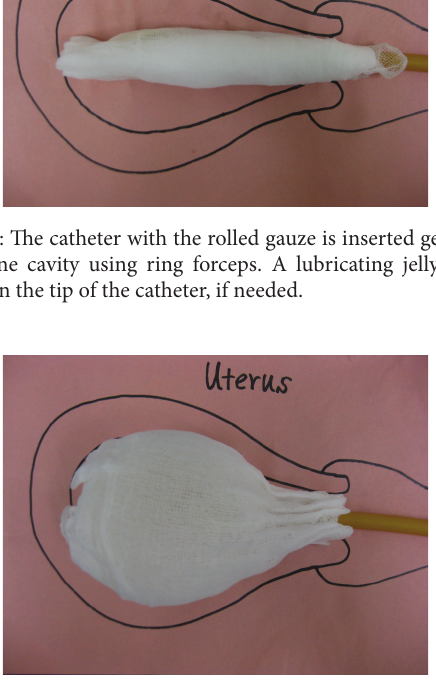
Figure 4: The balloon is inflated with sterile water until it bulges toward the cervix so that it can adequately compress the inner uterus and the tranexamic-acid-soaked gauze can adhere tightly to the bleeding spots. In addition, one-meter long normal gauze is packed in the vagina to prevent the balloon from slipping